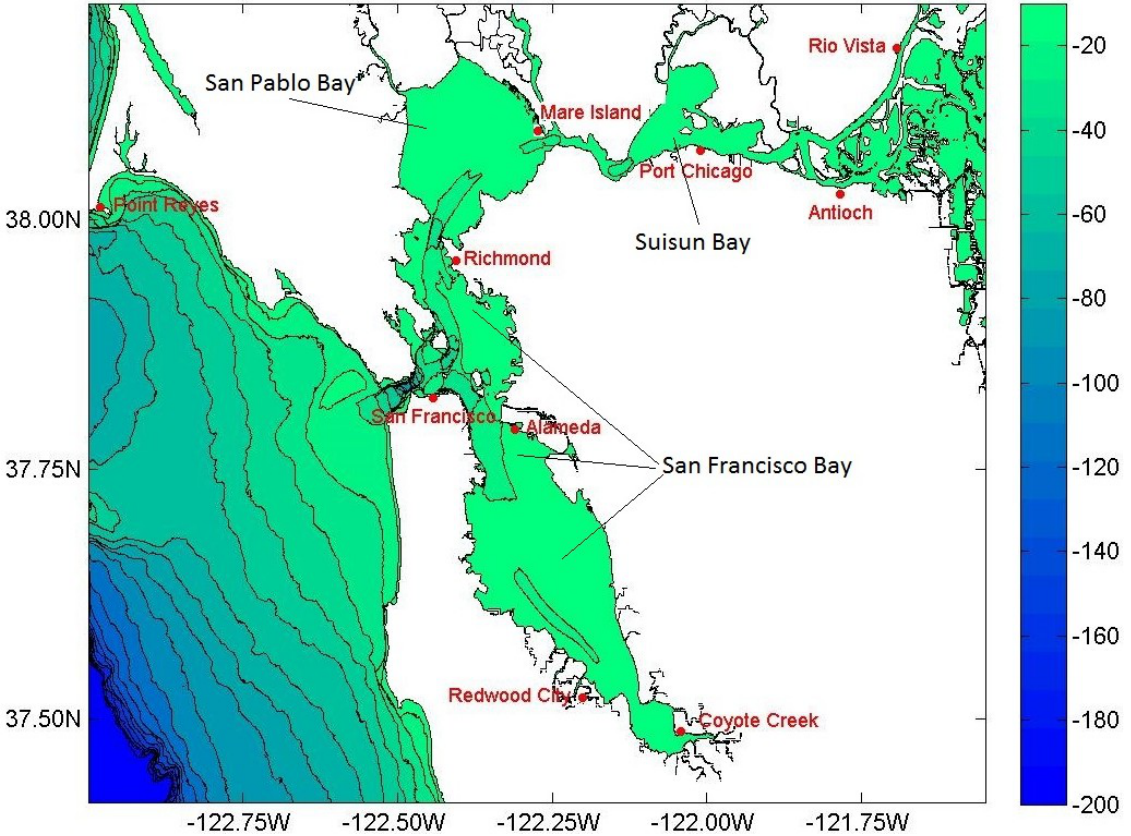
Figure 1. The bathymetry of San Francisco Bay Operational Forecast System and the major gauge stations. The definition of ―delta‖ in this paper is the region with complicated water channels to the east of Antioch and Rio Vista. The locations of the three major bays are indicated. Note: the domain in this figure is a little larger than the model grid domain as shown in Figure